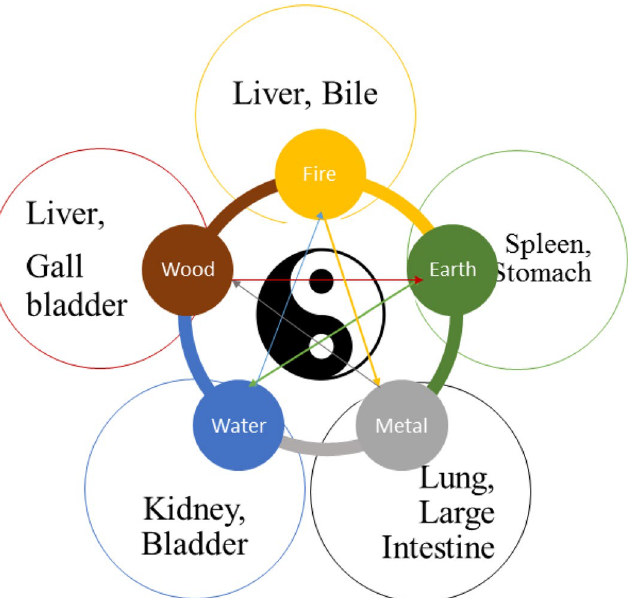
Figure 1. Five elements and Yin-Yang